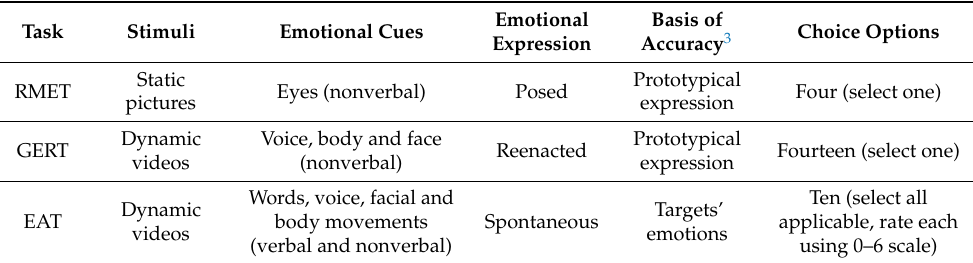
Table 1. Description of emotion recognition